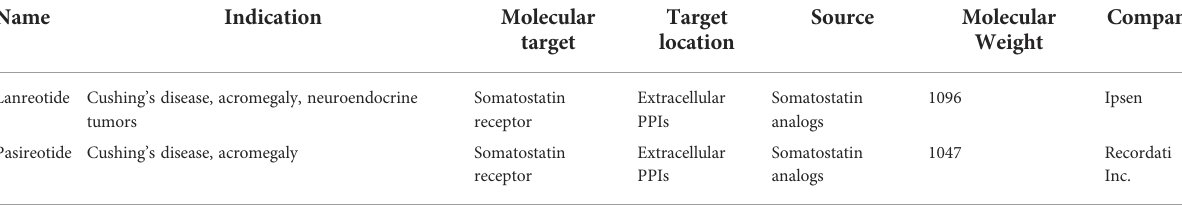
TABLE 2 Details of oncology macrocyclic peptide drugs approved by the FDA